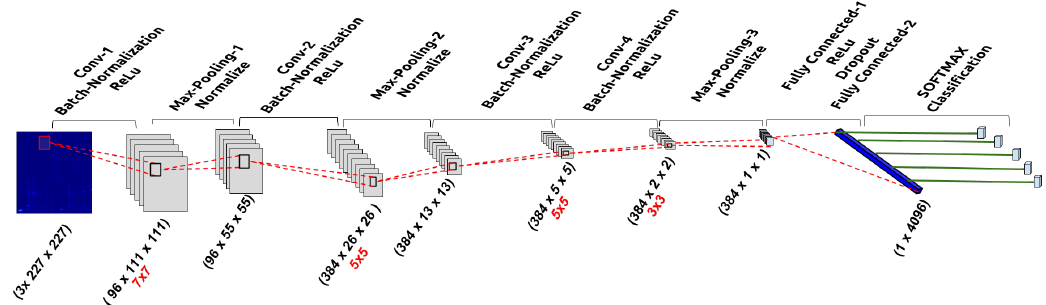
Figure 2. Proposed Convolutional Neural Network (CNN)-EM: